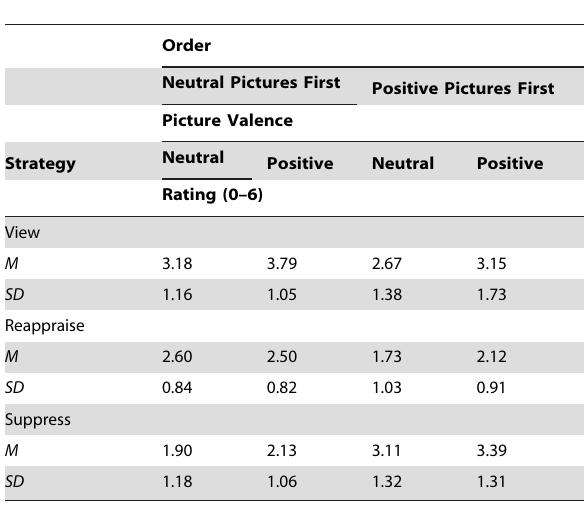
Table 1. Mean Positive Affect Ratings by